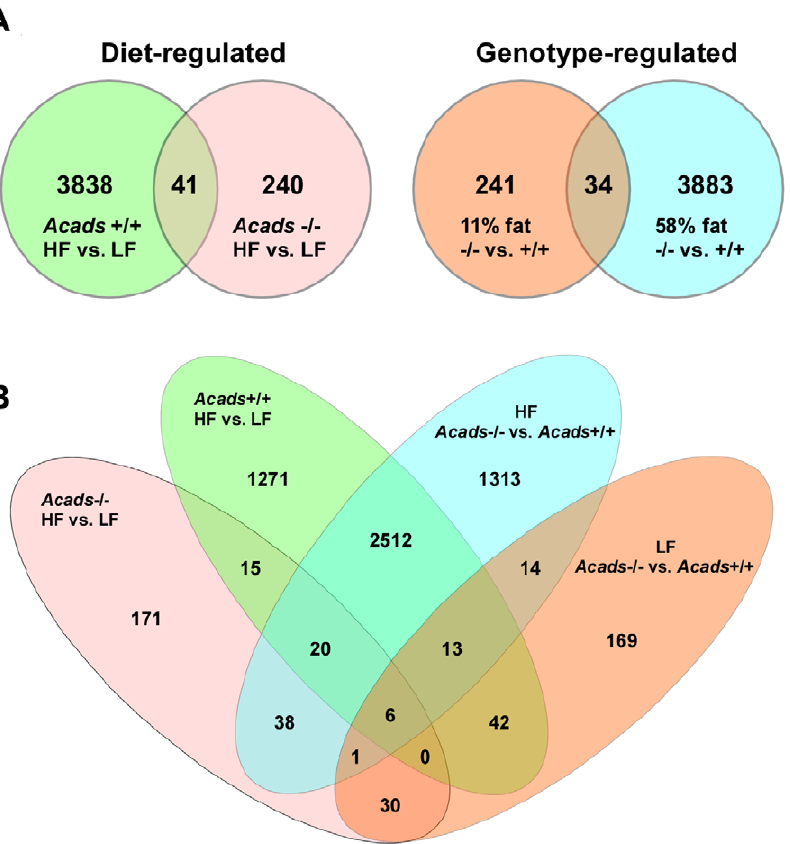
Figure 2. Venn diagrams of gene totals disturbed by genotype and diet. Two-way (A) and four-way (B) Venn diagrams of diet and genotype effects on gene expression in Acads 2 / 2 and Acads + / + mice fed high- or low-fat diet. Only genes with changes . 1.6-fold and P , 0.05 were included. See Table 1 for the total number of differentially expressed genes for each of the four comparisons. Within each main comparison (e.g., separate colors in B), the overlap from sub-categories was subtracted from the total number of diet- or genotype-regulated transcripts. Only six transcripts were found in common among all four comparisons. doi:10.1371/journal.pone.0041709.g002 PLOS ONE |